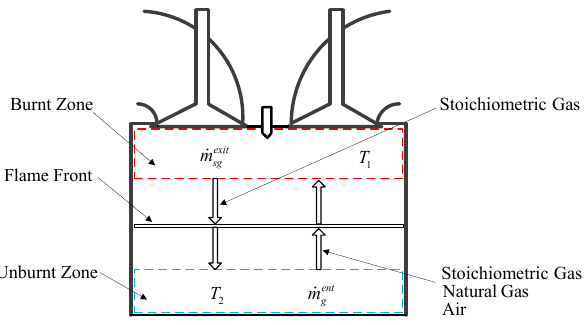
Figure 2. Mass and energy exchange in the two-zone model.